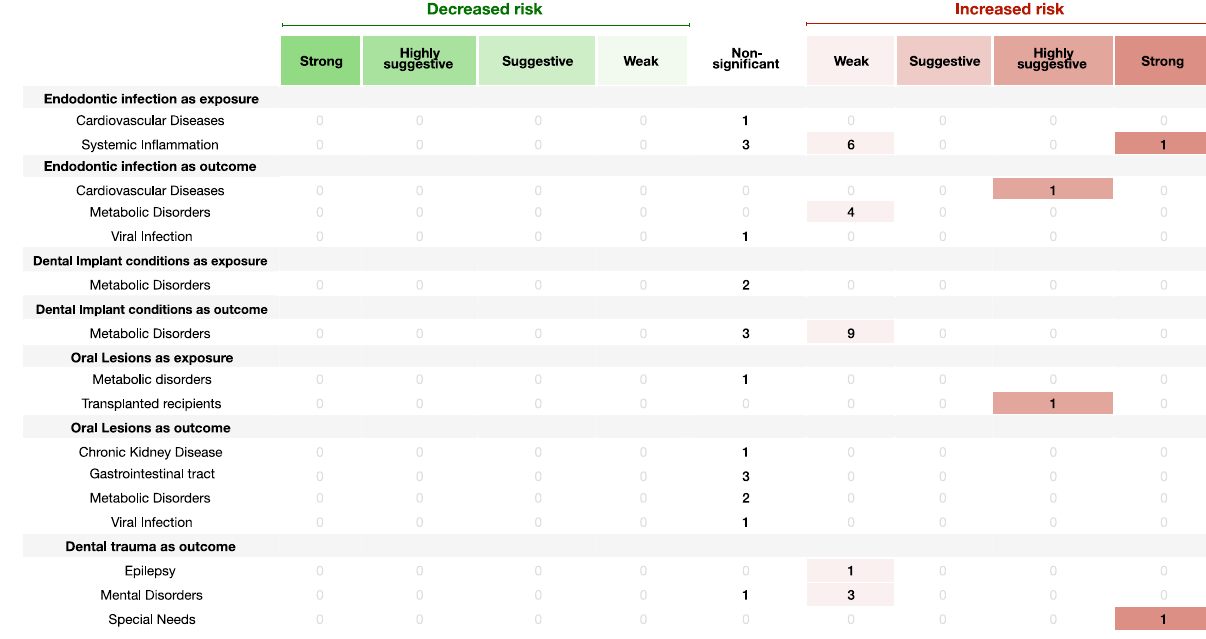
Fig. 3 | Evidence grading diagram on endodontic infection, dental implant conditions,orallesionsanddental(bothasexposureandoutcome)ofanNCD. TherightsidedisplaysassociationsthatincreasetheriskfortherespectiveNCD(in